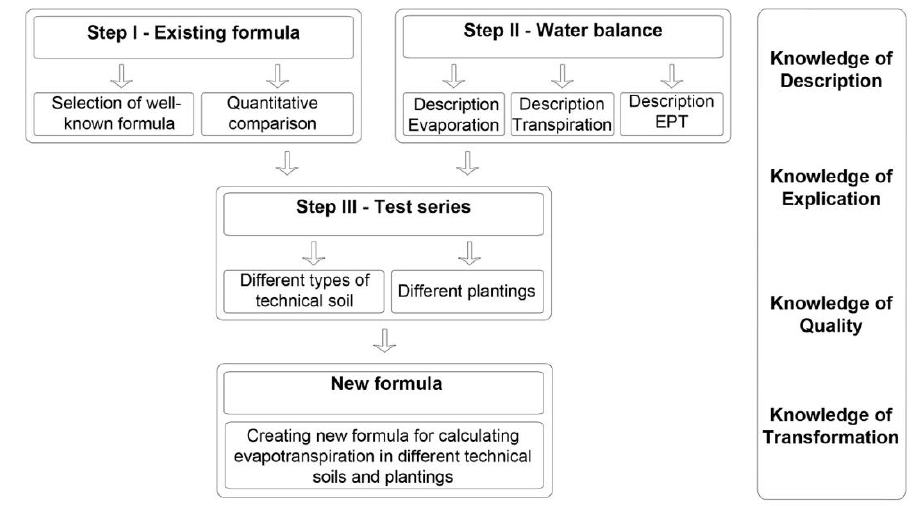
Figure 1. Overview of the used research design (based on Weiss et al., 2019 [19]) .